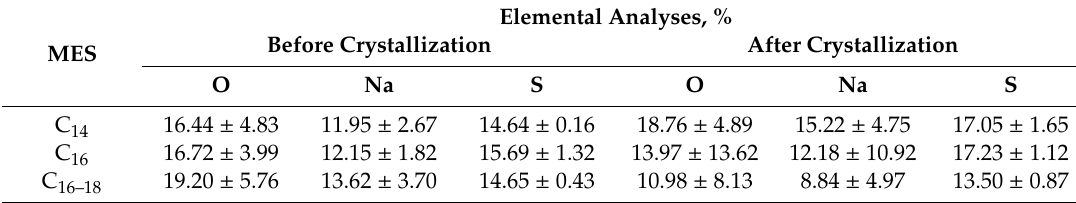
Table 4. Elemental analyses of MES.